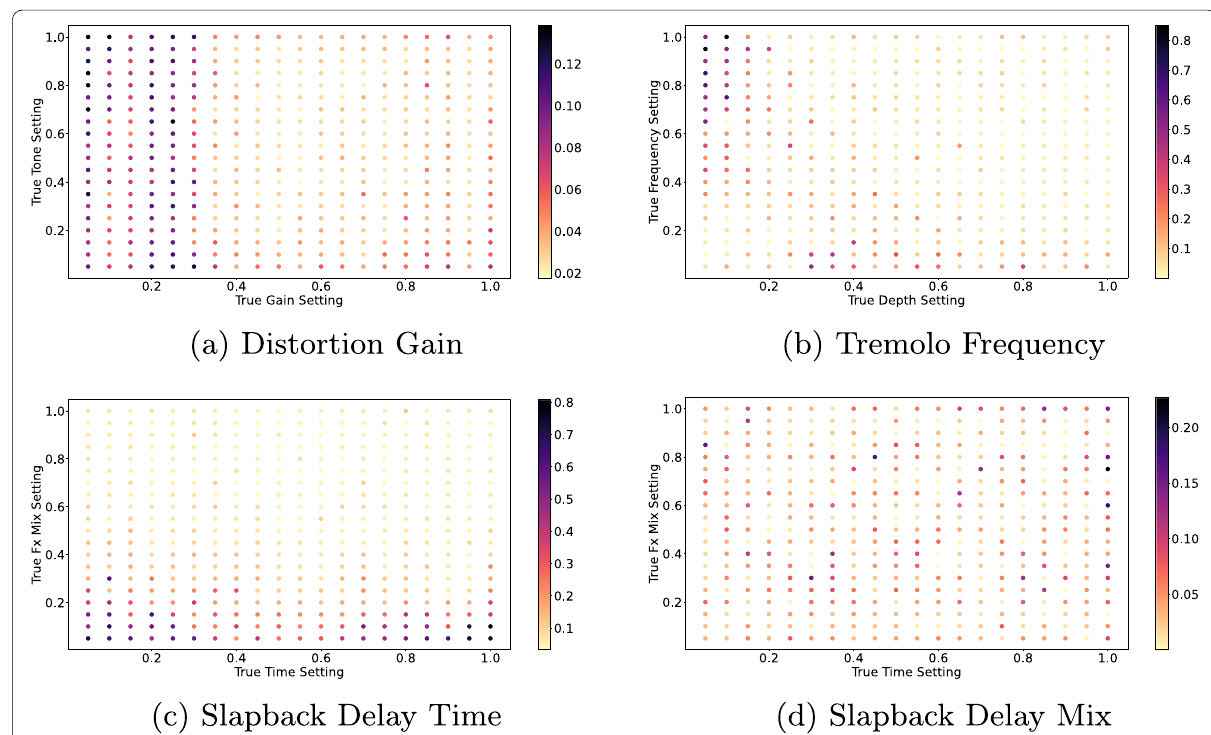
Fig. 15 Maximum of the absolute parameter extraction error for the a distortion gain, b tremolo frequency, c slapback delay time, and d slapback delay mix parameter across the ground truth parameter settings. The maximum was taken across the fivefold cross